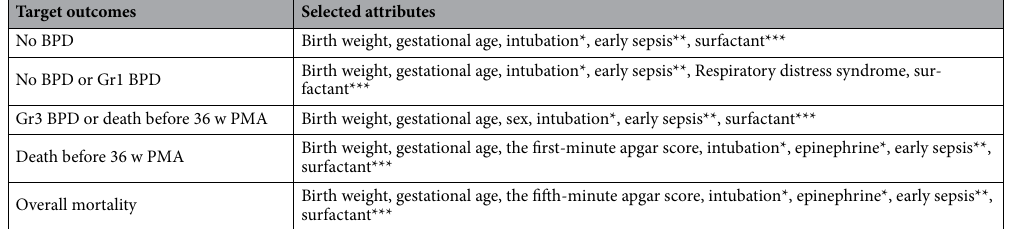
Table 4. Attributes selected for various target outcomes by weka. BPD Bronchopulmonary dysplasia; Gr Grade; PMA Postmenstrual age. *Had received intubation or epinephrine administration during neonatal resuscitation in the delivery or operation room. **A positive culture report from a blood sample and/or a cerebrospinal fluid sample obtained on day 1, 2, or 3 of life. ***Exogenous surfactant administrated at any time and through any